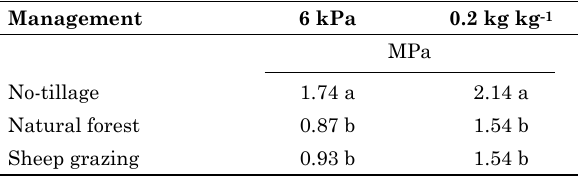
Table 4. Soil resistance to penetration (RP) for different management systems at